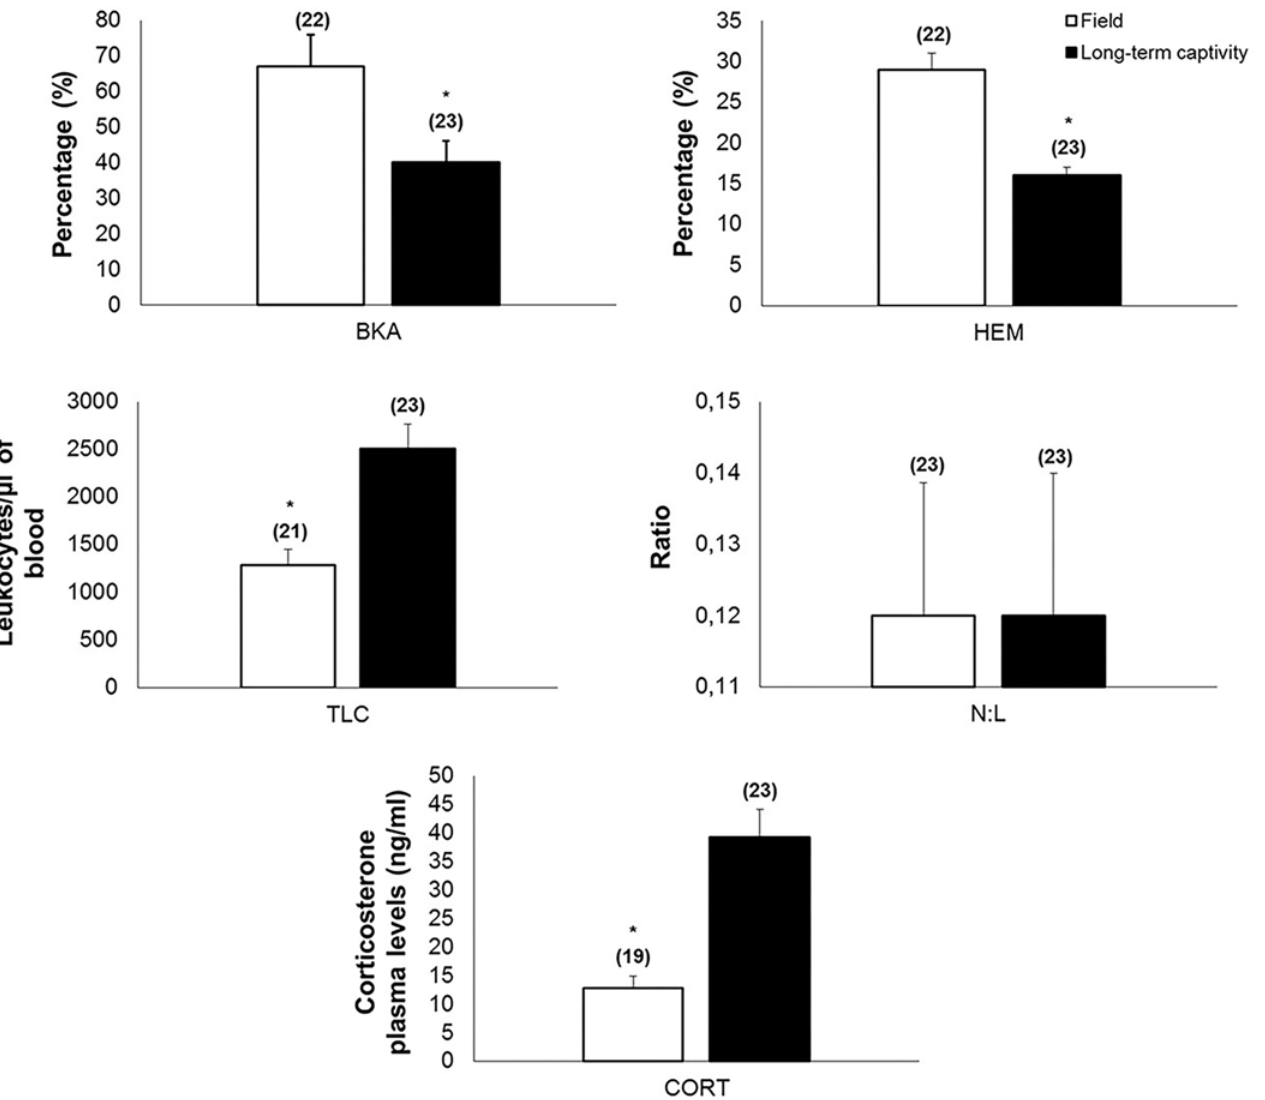
Fig 3. Blood paramenters — comparison between baseline and after long-term captivity. Comparison of blood parameters of toads ( Rhinella icterica ) in the field and after long-term captivity (three months). Bars represent mean ± standard error with N in parentheses. BKA : Bacterial killing ability; HEM : Hematocrit; N:L : Neutrophil/ Lymphocyte ratio; TLC : Total Leukocytes Count; CORT : Corticosterone plasma levels. * P (cid:2) 0.001.